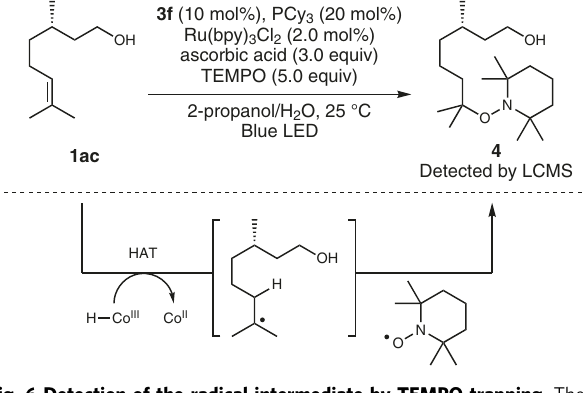
Fig. 6 Detection of the radical intermediate by TEMPO trapping. The formation of TEMPO adduct supports the presence of alkyl radical intermediate which is likely to be formed by HAT to 1ac; Cy cyclohexyl, bpy 2,2 ’ -bipyridyl, TEMPO